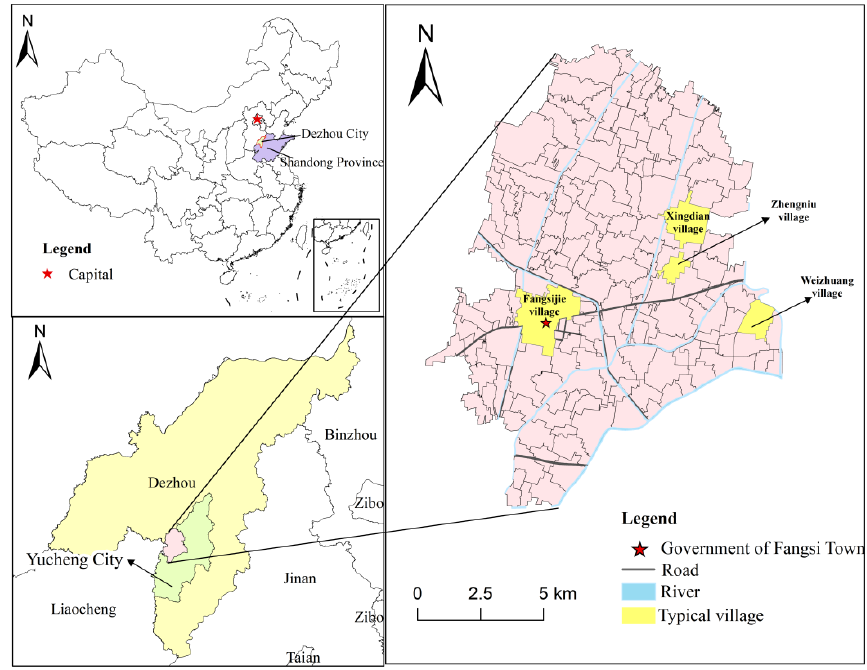
Figure 5. Research